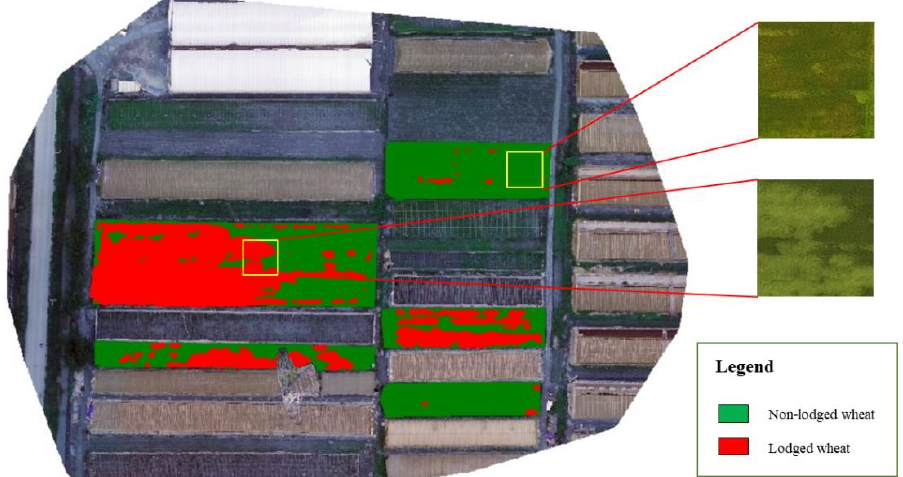
Figure 4. Illustration of UAV dataset of lodged and non-lodged wheat.